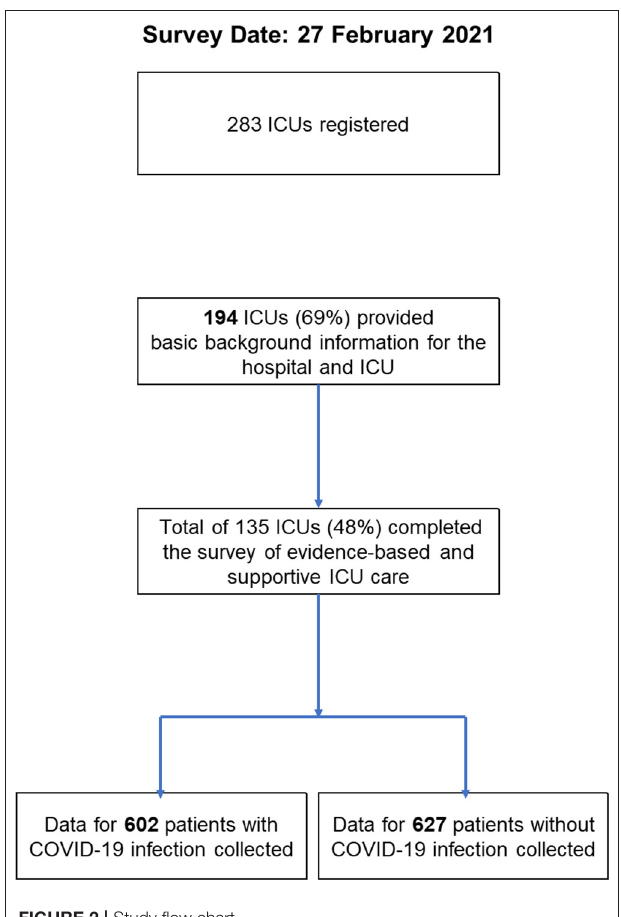
FIGURE 2 | Study flow chart.